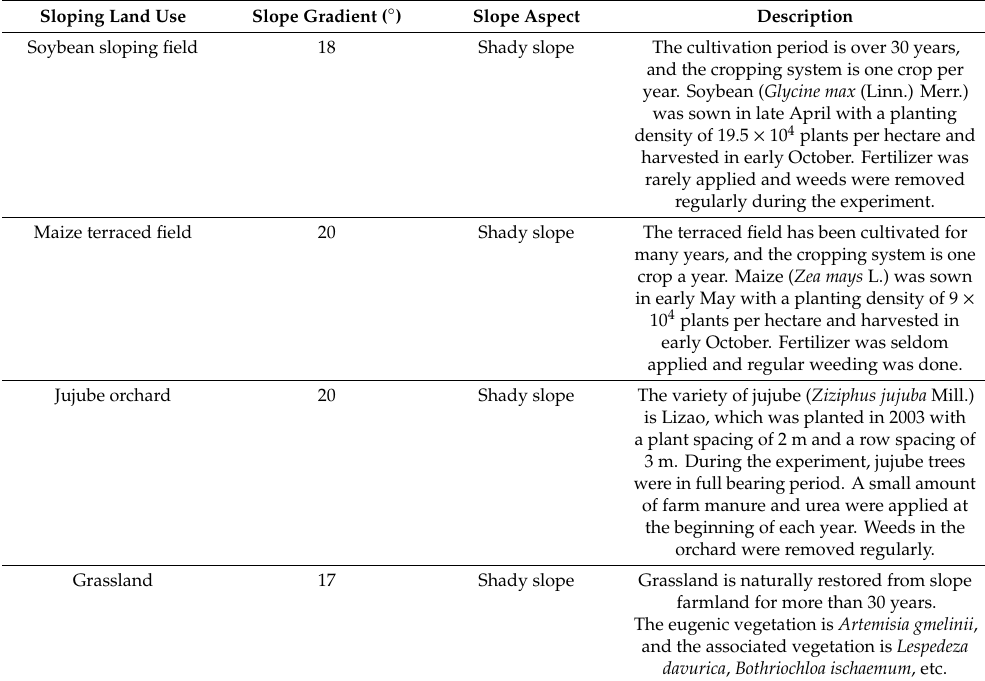
Table 1. General information of experimental land